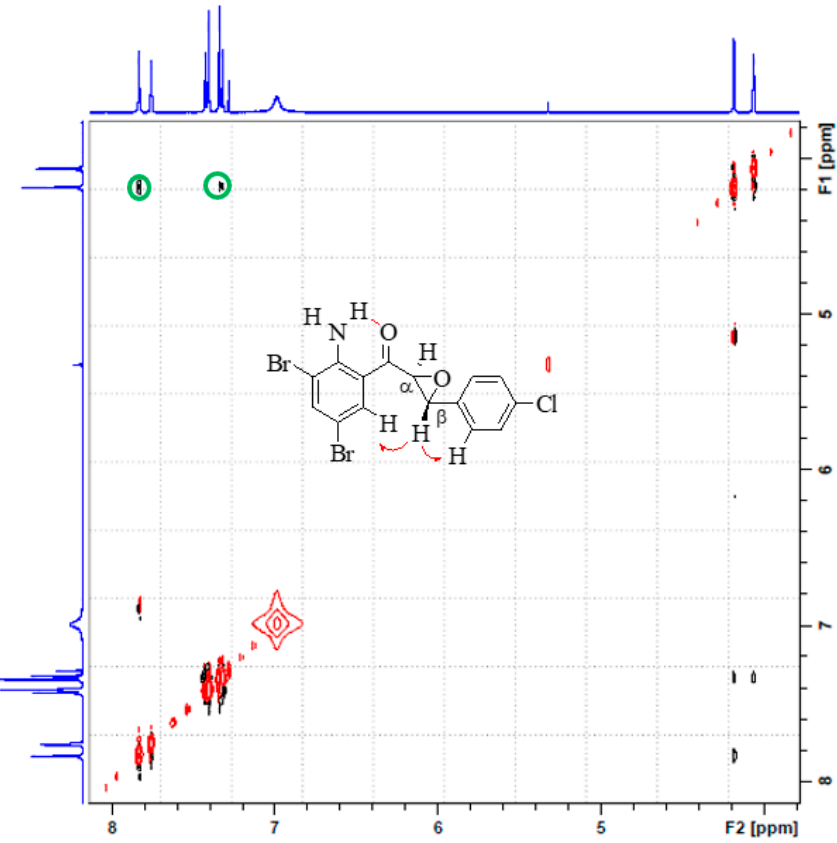
Figure 2. NOESY Spectrum of 2c showing dipole–dipole interaction between β -H and the ring-A and B protons.